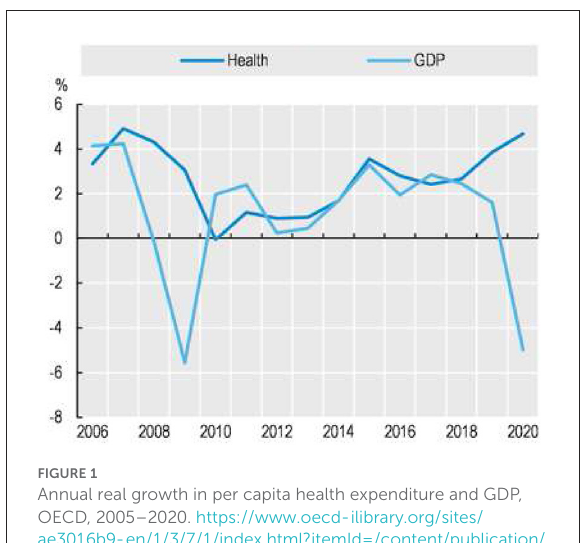
FIGURE1 Annual real growth in per capita health expenditure and GDP, OECD, 2005–2020. https://www.oecd-ilibrary.org/sites/ ae3016b9-en/1/3/7/1/index.html?itemId=/content/publication/